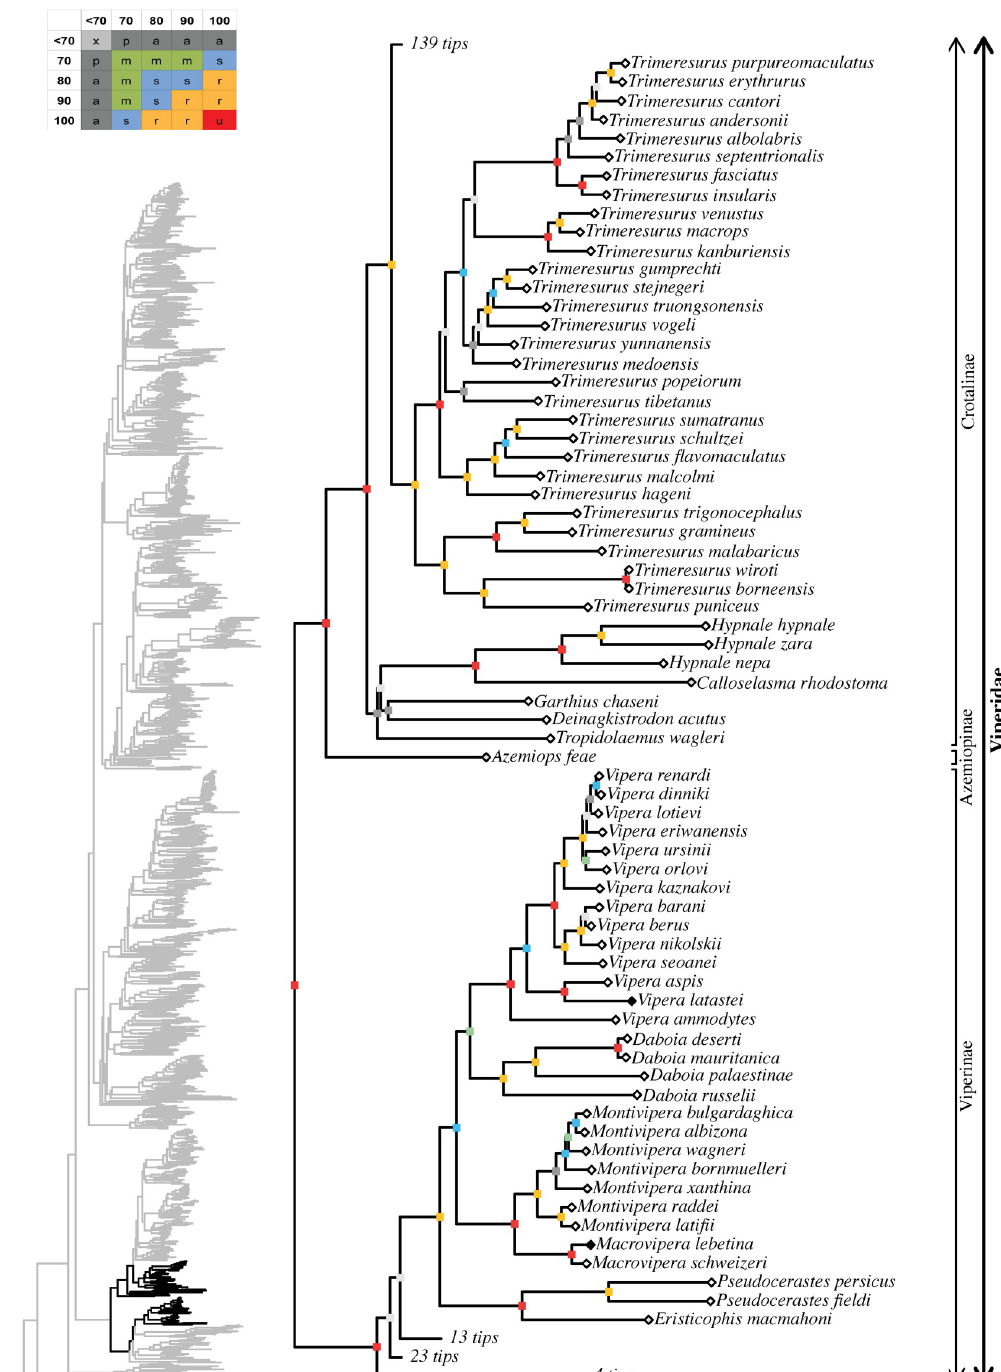
Fig 7. Maximum likelihood species-level phylogeny of Colubroides (continued). Family Viperidae, subfamilies Viperinae, Azemiopinae,